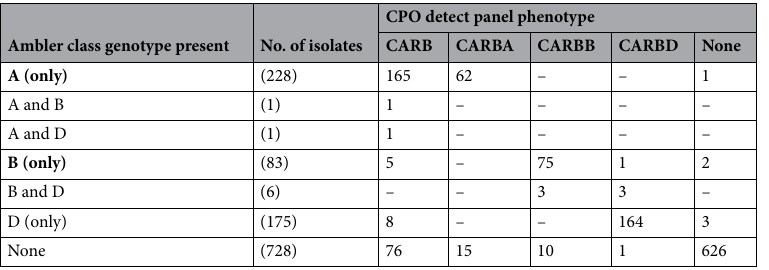
Table 3. Summarized data on various phenotype results of different Ambler classes